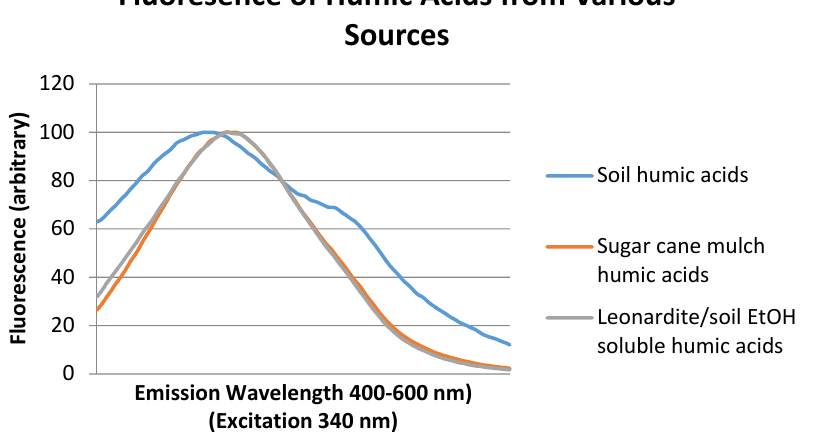
Figure 2. Fluorescence spectra of humic acids extracted from soil, sugar cane mulch, and Leonardite coal (NZ) (Leonardite/soil ethanol-soluble extracts were identical, so only one trace is shown).